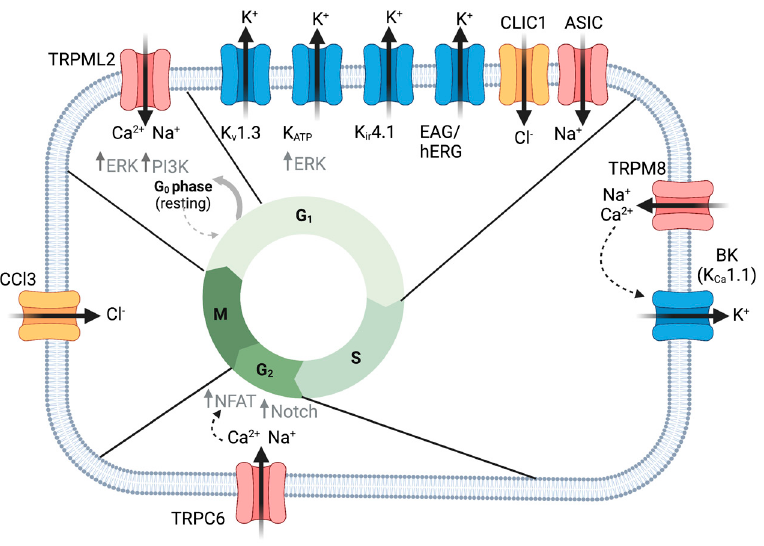
Figure 1. Ion channels regulate glioma cell proliferation. TRPML2 mediates exit from quiescence via increased ERK and PI3K growth signaling. Several K + channels, as well as CLIC1 and ASIC channels, are important in the G1 to S phase transition of the cell cycle. KATP promotes ERK growth signaling. TRPM8 increased intracellular Ca 2+ important for activating BK channels driving S to G2 cell cycle transition. TRPC6-mediated Ca 2+ enhances Notch signaling and NFAT translocation to the nucleus, promoting G2 to M phase transition. CCL3-mediated premitotic condensation is important for proliferation. Created with BioRender.com.